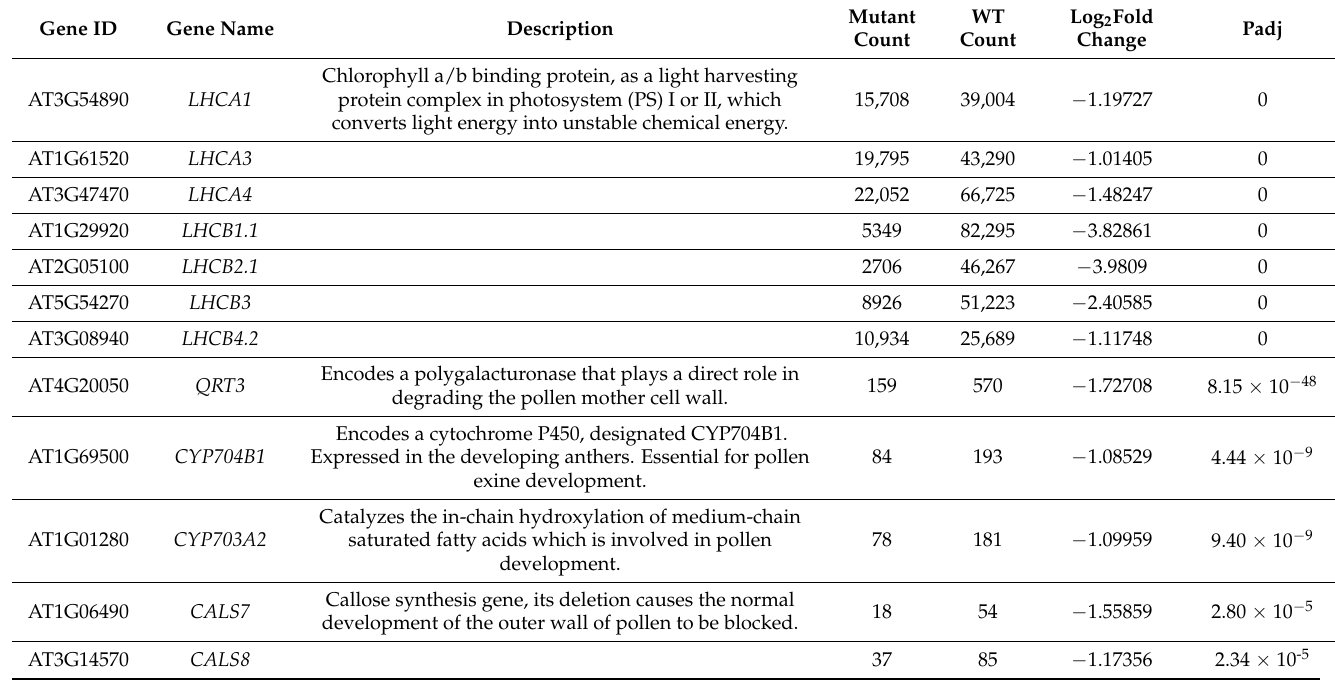
Figure 8. Transcriptome analysis of the WT and pip1s – mutant plants. ( A ) The number of DEGs in terms of transcript abundance in rosette leaves and siliques from the WT and pip1s - mutant plants. ( B ) Venn diagram showing the number of DEGs in the two comparison groups (muleaf vs. WT and musili vs. WT). ( C , D ) Volcano plots showing up-regulated and down-regulated of DEGs in the comparisons of muleaf with WTleaf ( C ) and musili with WTsili ( D ). Table 1. DEGs analysis related to growth and development of the pip1s - mutant and the